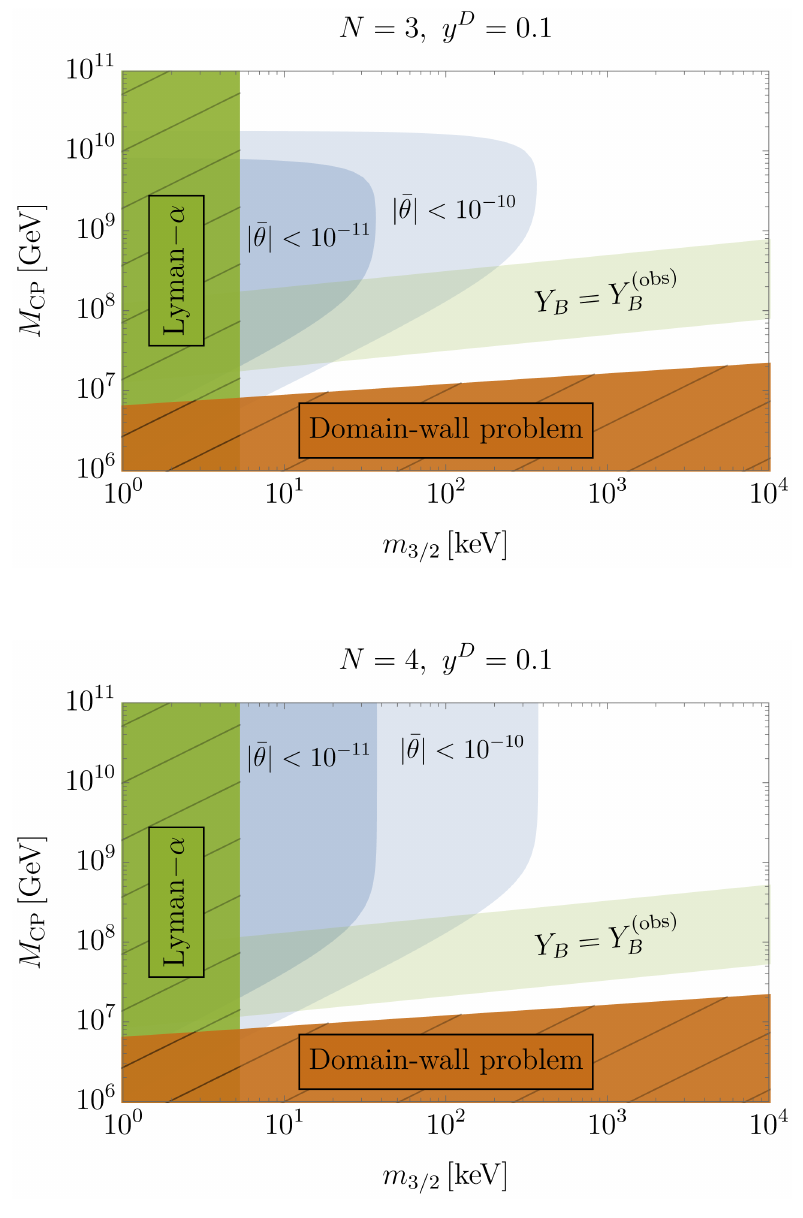
Figure 4 . The prediction of ¯ θ on ( m , M CP ) -plane for m soft = 10 TeV , y D = 0 . 1 with N = 3 3 / 2 (upper panel) and N = 4 (lower panel). We take the reheating temperature such that the gravitino abundance is equal to the observed DM abundance. The meshed green- and brown-colored regions are excluded because of the Lyman- α constraint and by the domain wall formation, respectively. The light blue shaded regions show ¯ θ < 10 − 10 , 10 − 11 , whereas the light green shaded region shows Y B = Y (obs)